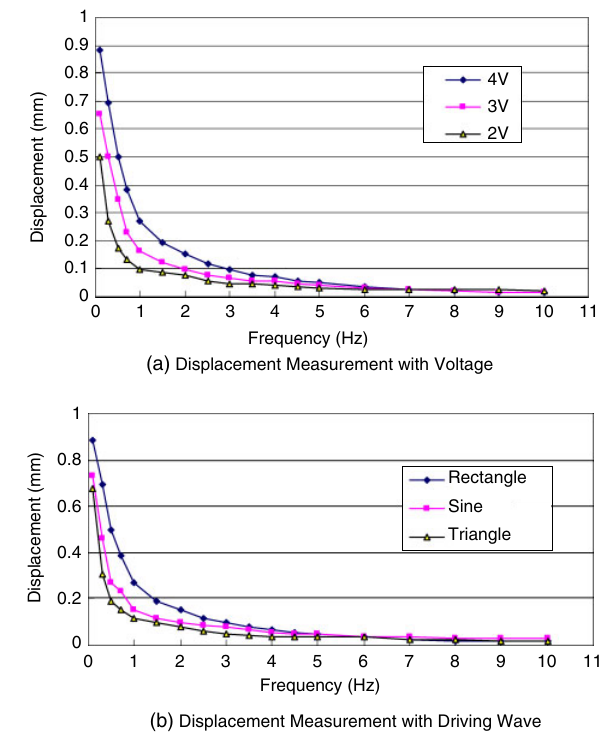
Figure 9 Experimental results of the displacement (in air). (a) Displacement measurement with voltage, (b) displacement measurement with driving wave.